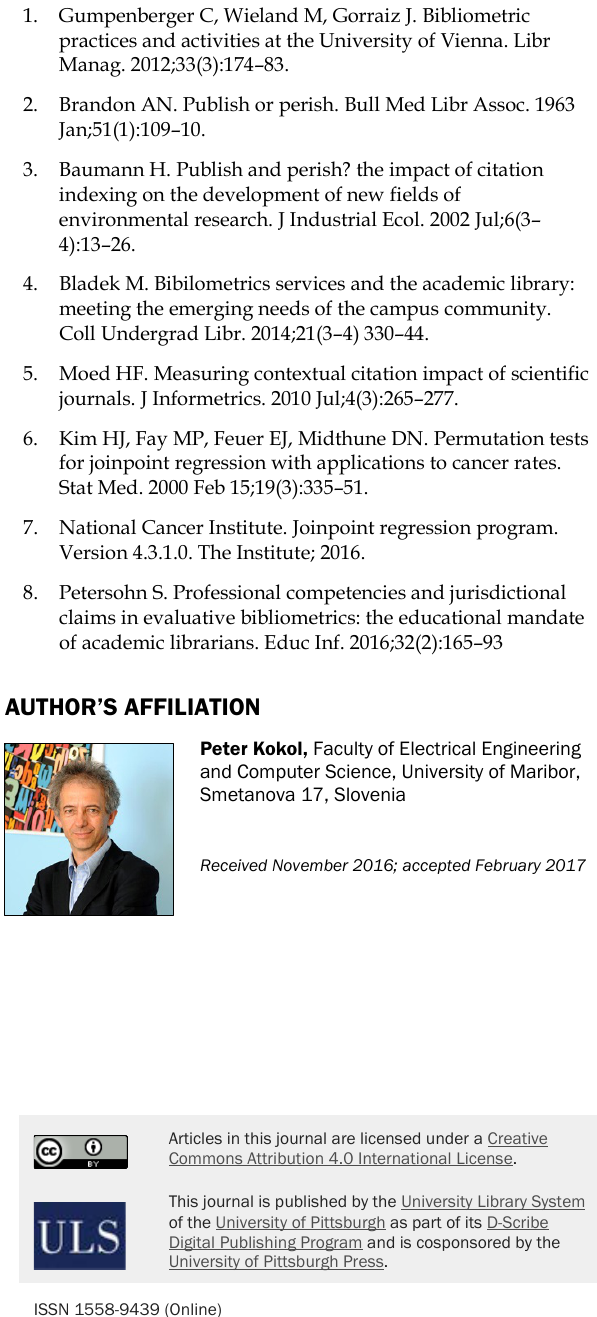
SNIP values in the y-axis are shown without a decimal point (e.g., a SNIP value of 1.00 is represented as 100). With 2 positive and 2 negative trend lines